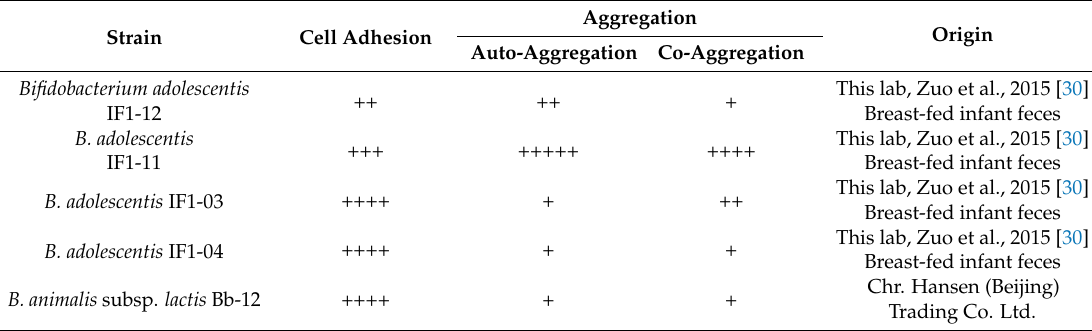
Table 1. Bifidobacterium strains used in this